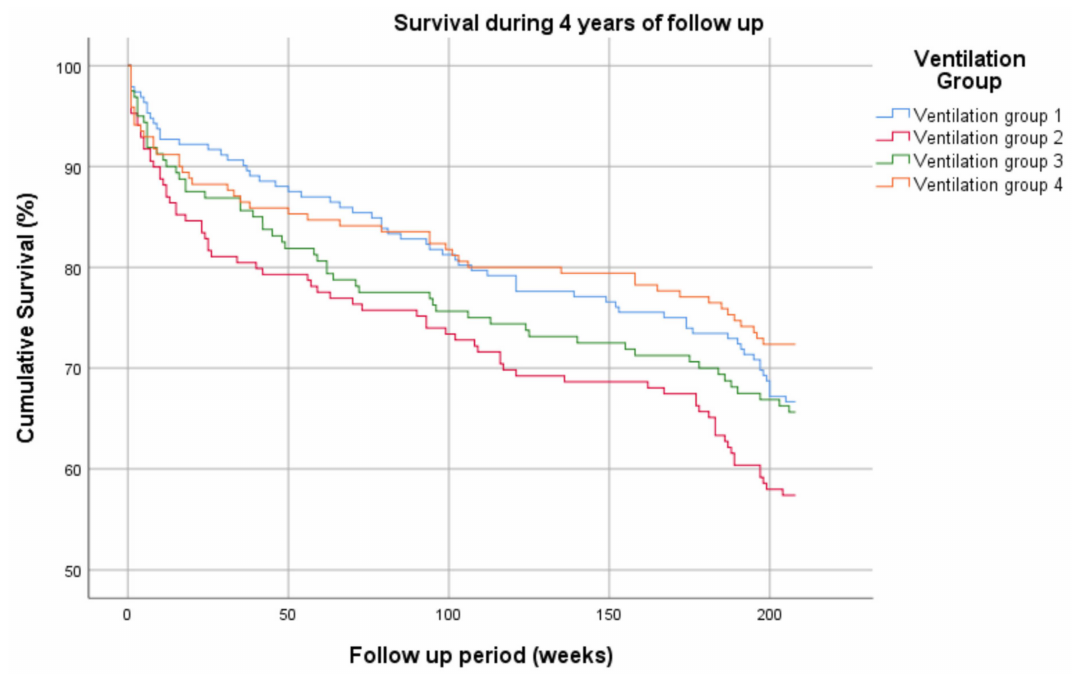
Figure 2. Four-year survival according to Kaplan–Meier analysis for four groups that differed by the duration of invasive mechanical